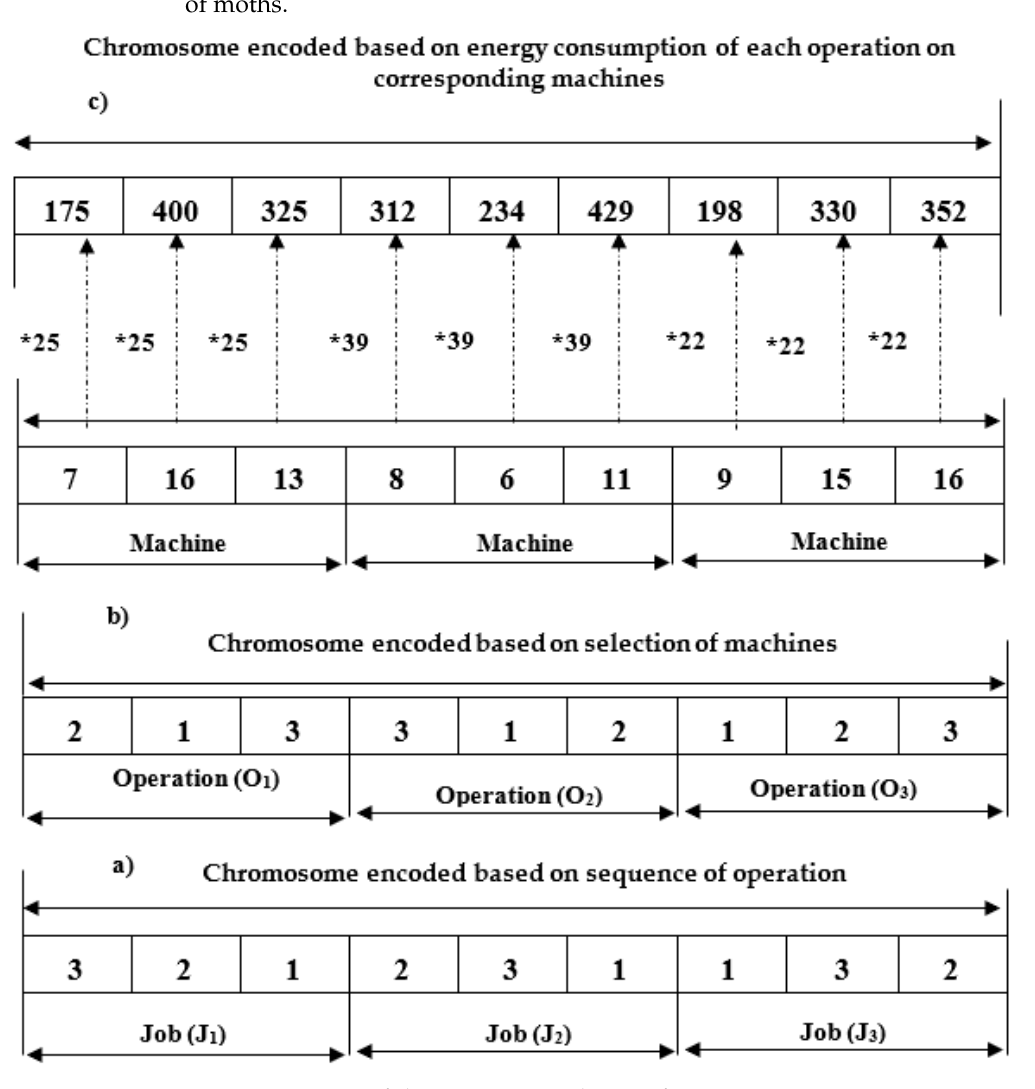
Figure 9. Representation of chromosome initialization for energy consumption.